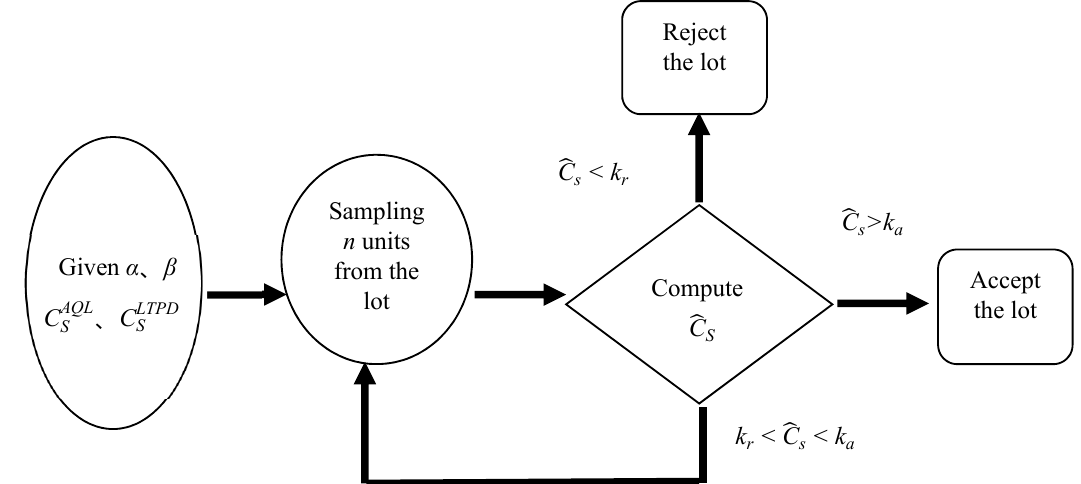
Figure 1. Flow chart of a repetitive sampling plan based on C S .